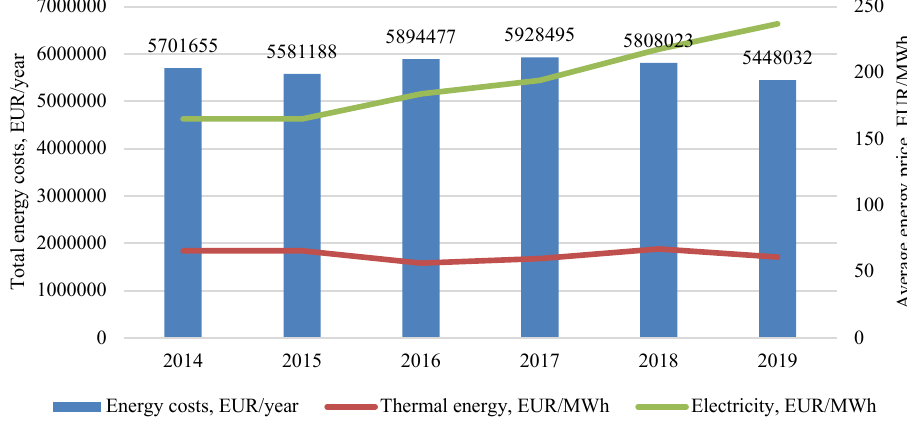
Fig. 11. Energy costs in 123 municipal buildings in the city of